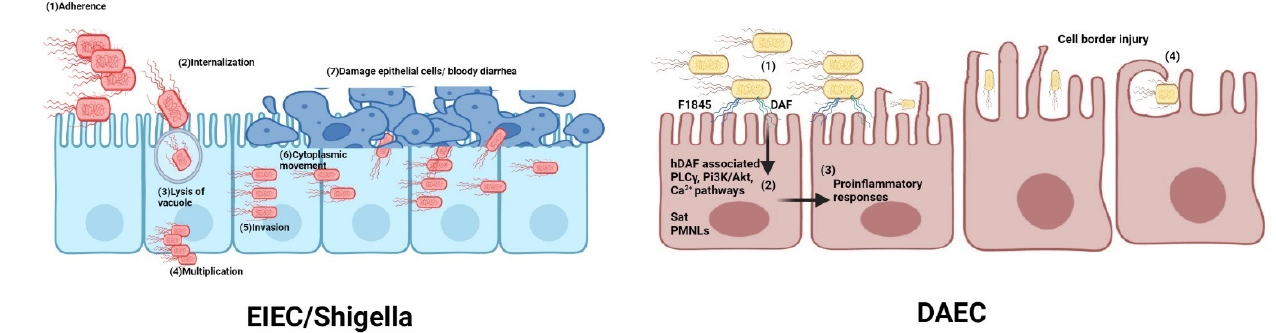
Figure 2. Pathogenesis of EIEC and DAEC. Shigella /EIEC show similar types of pathogenesis. EIECs adhere to the basolateral surface of enterocytes and form a pore in the host membrane (1). Invasion plasmid antigens (IPAs) mediate the uptake of EIEC into enterocytes (2), which is followed by a process of host cell entry (3), multiplication (4) and intercellular spread of EIEC (5,6), ultimately leading to death of the enterocyte (7). Following escape from the entry vacuole (3), Shigella/EIEC drives actin polymerization at one pole through IcsA-dependent recruitment of N-WASP and ARP2/3. This allows for intracellular motility. Invasive bacteria released from damaged enterocytes induce another wave of uptake by phagocytosis in healthy cells and then repeat the cycle of survival and replicate or disseminate from cell to cell via an actin-based motility process. DAECs are characterized by the diffuse adherence pattern on cultured epithelial cells. Around 75% of DAEC harbor adhesins from the Afa/Dr family, responsible for this adherence phenotype. The infection starts with the interaction of Afa/Dr family of adhesins with membrane-bound receptors, including decay-accelerating factor (DAF) by Afa/Dr/DAF adhesins (AfaE-I, AfaE-II, AfaE-III, AfaE-V, Dr, Dr-II, Nfa-1, and F1845) (1). A signaling pathway involving protein tyrosine kinase(s), phospholipase C γ , phosphatidylinositol 3-kinase, protein kinase C, and an increase in [Ca2+] that controls the rearrangements of brush border-associated F-actin induce structural changes of microvilli (2). Sat, serine protease toxin secreted by DAEC can change the paracellular permeability, resulting in fluid accumulation in the intestine. Host interactions with Afa/Dr adhesins can induce migration of polymorphonuclear leukocytes (PMNLs) (3) which promotes the production of proinflammatory cytokines which in turn promote the upregulation of DAF (3). It was reported that finger-like projections are induced in enterocytes due to signal transduction caused by DAEC (4). The figure was created with BioRender.com (accessed on 22